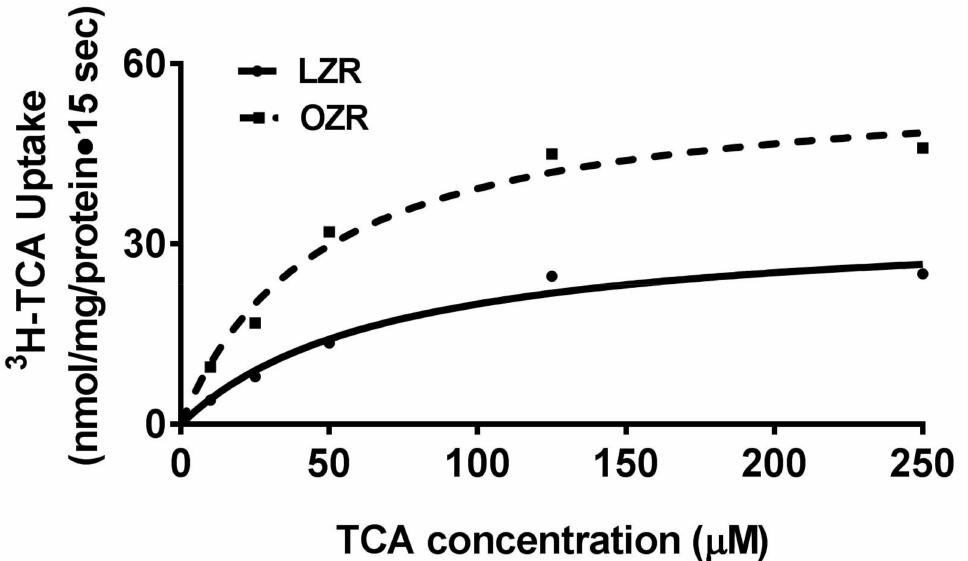
Figure 2. Villus cell BBM Na–bile acid cotransport kinetics in Zucker rats. A representative graph of kinetics of Na-taurocholate cotransport in BBMV prepared from OZR compared to LZR is shown. As the concentration of extravesicular taurocholate (TCA) increased, Na–bile acid uptake was stimulated, but subsequently became saturated in both the experimental conditions. The kinetic parameters derived from n = 4 of such experiments are shown in Table 1. While the maximal rate of uptake ( V max ) was increased in OZR, the a ffi nity for taurocholate uptake (1 / K m ) was unchanged between OZR and